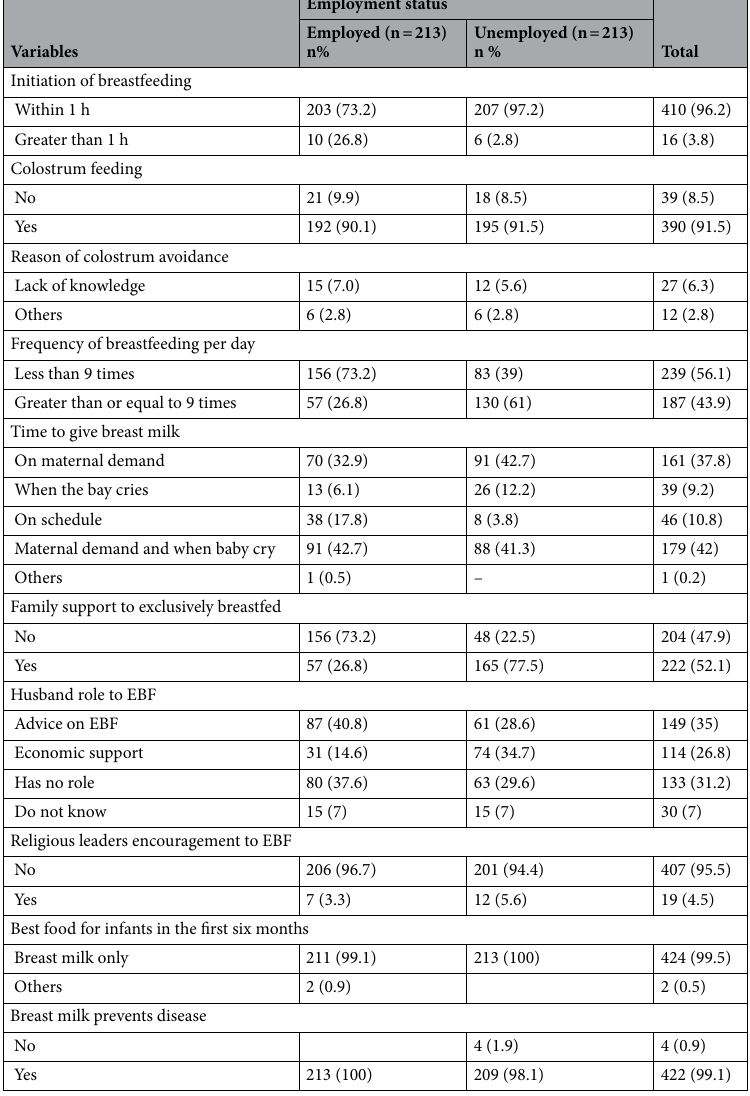
Table 4. Breastfeeding practice and perception of mothers at Debre tabor town, Northwest Ethiopia,